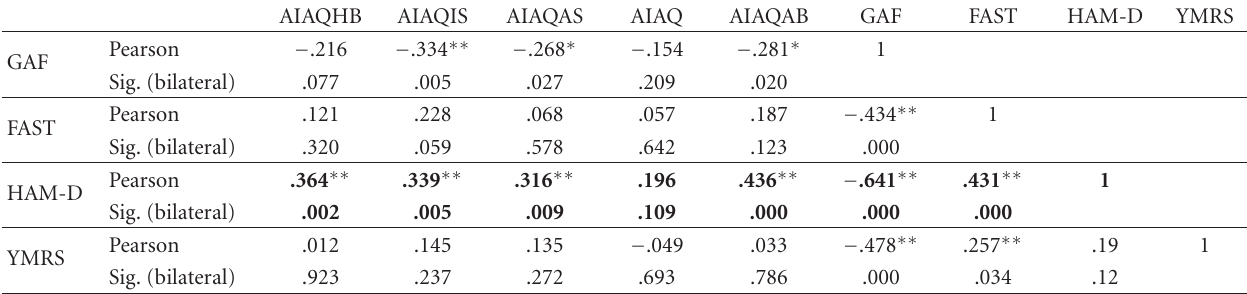
∗∗ Significant correlation at level .01 (bilateral). ∗ Significant correlation at level .05